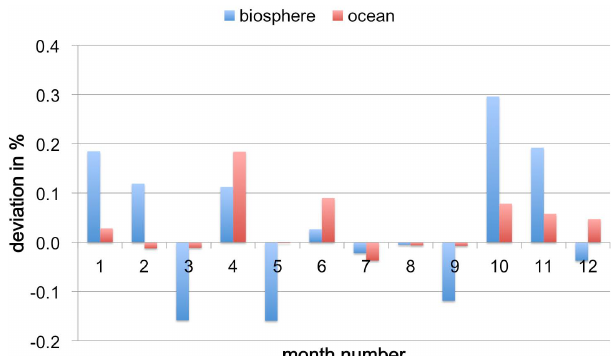
Fig. A1. Relative error in percent between RMS error for spatial variability of original fields and RMS error for spatial variability of fields restored with EOFs for two kinds of sources depends on month.